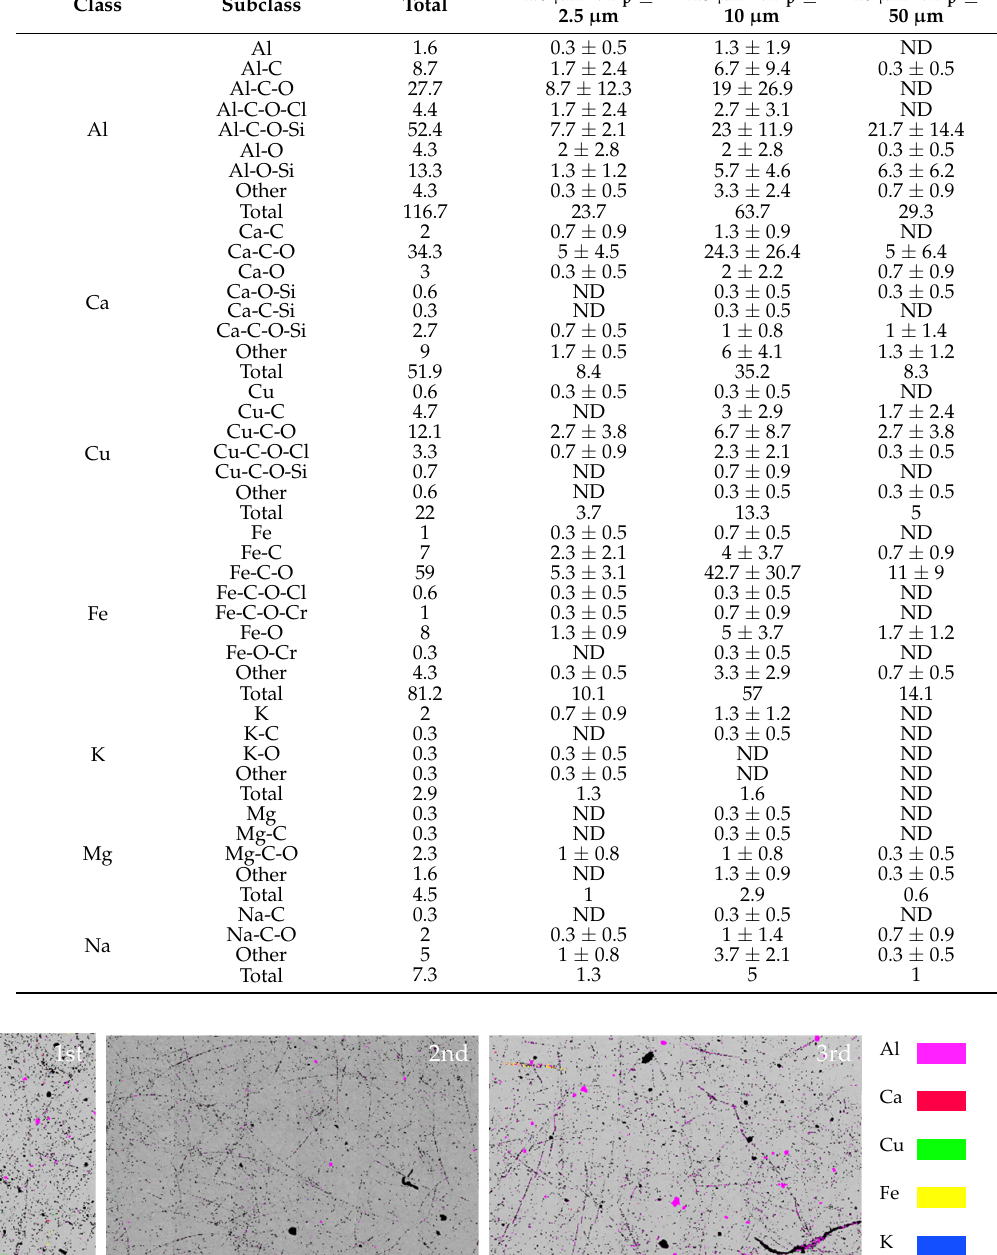
Table 2. Major chemical categories and their normalized average particles (size: 1 µ m < Dp) of metal compound from incineration experiment of waste mulching LDPE collected in DangJin (unit: ea).